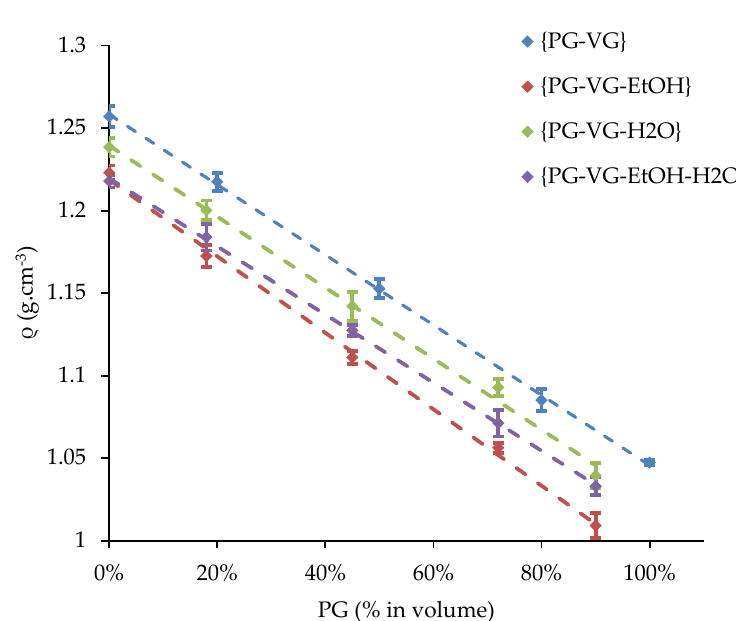
Figure 4. Influence of the PG volume fraction of {PG-VG}, {PG-VG-EtOH}, {PG-VG-H 2 O}, and {PG-VG-EtOH-H 2 O} mixtures on their densities (measured at ambient temperature).